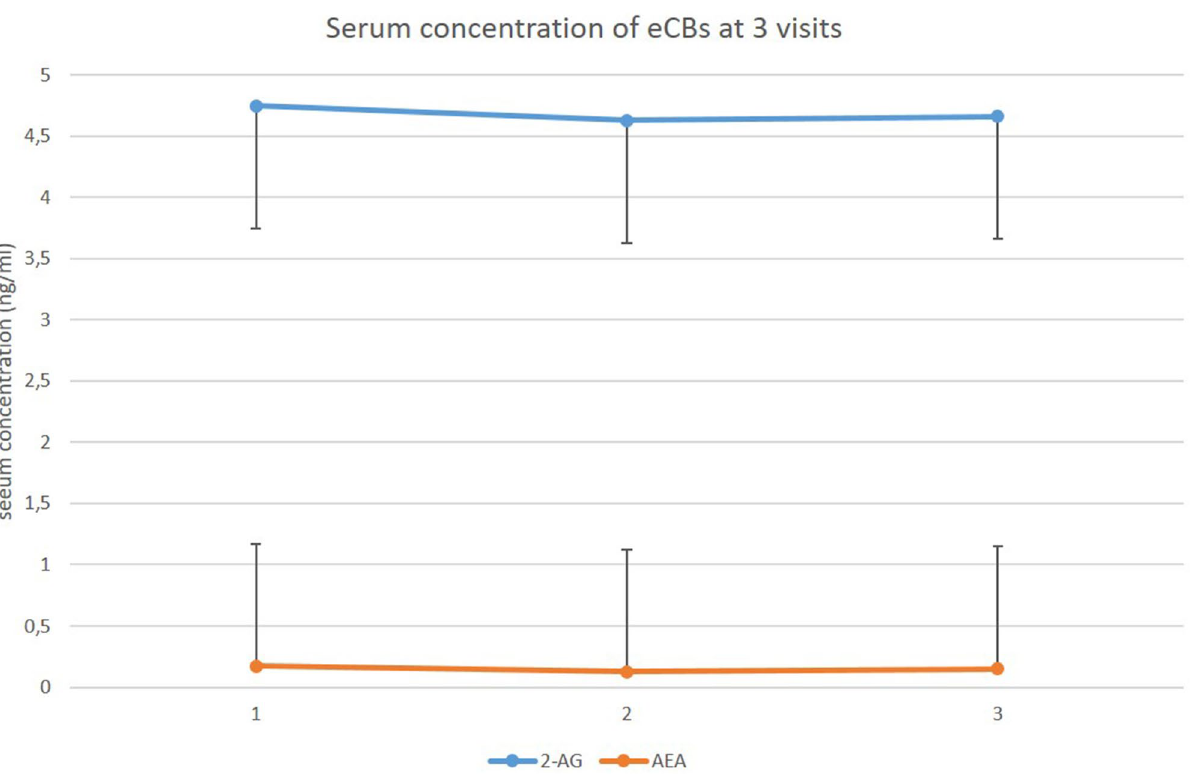
Figure 1. Serum concentration of circulating eCBs at visit 1 , visit 2 and visit 3 . Means and standard deviations (S.D.) are presented. 2-AG 2-arachidonoylglycerol, AEA